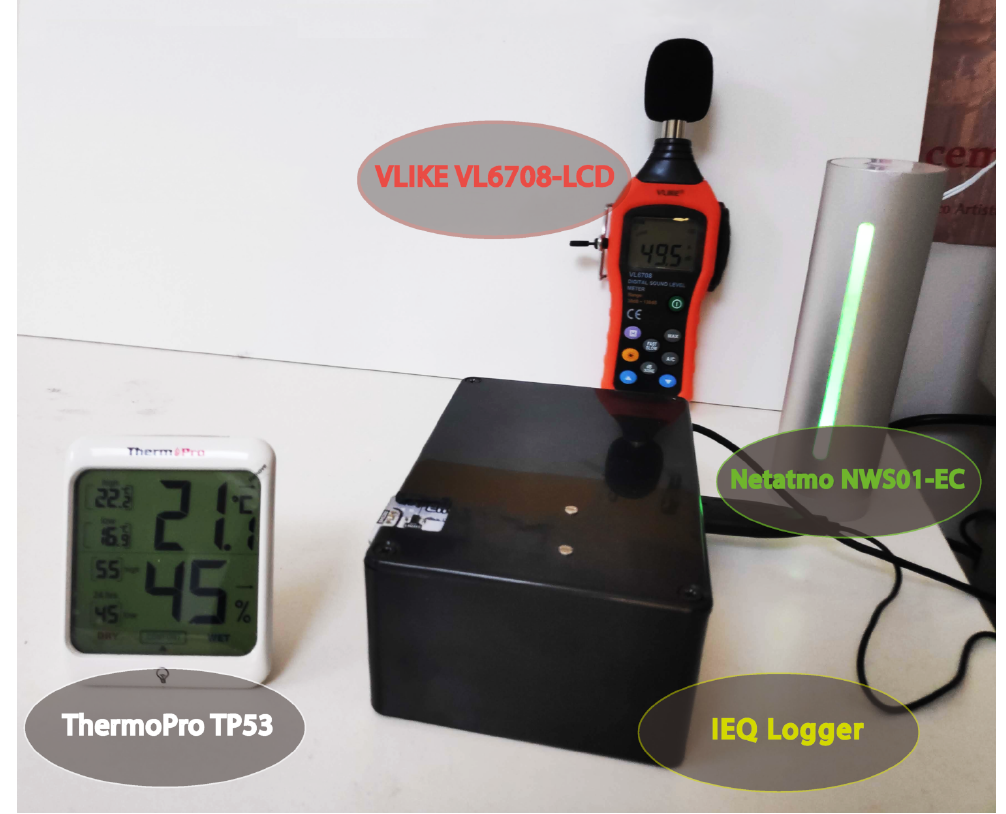
Figure 3. Instruments during calibration and testing phases.